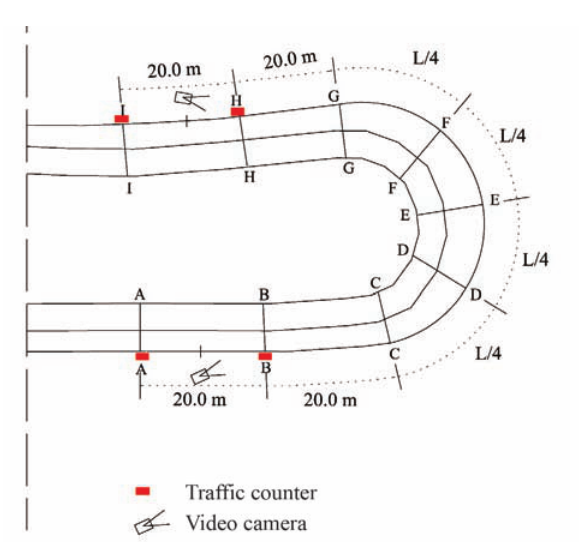
Fig. 2. Instrument position on hairpin